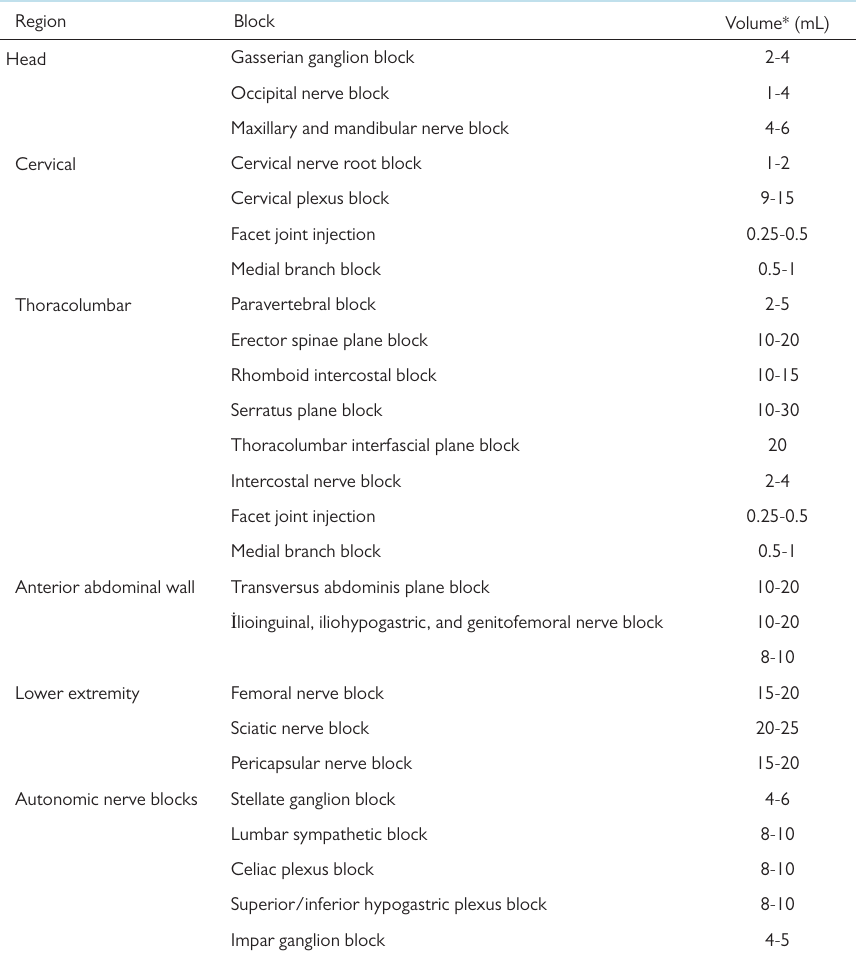
Table 1. Block Techniques for Chronic